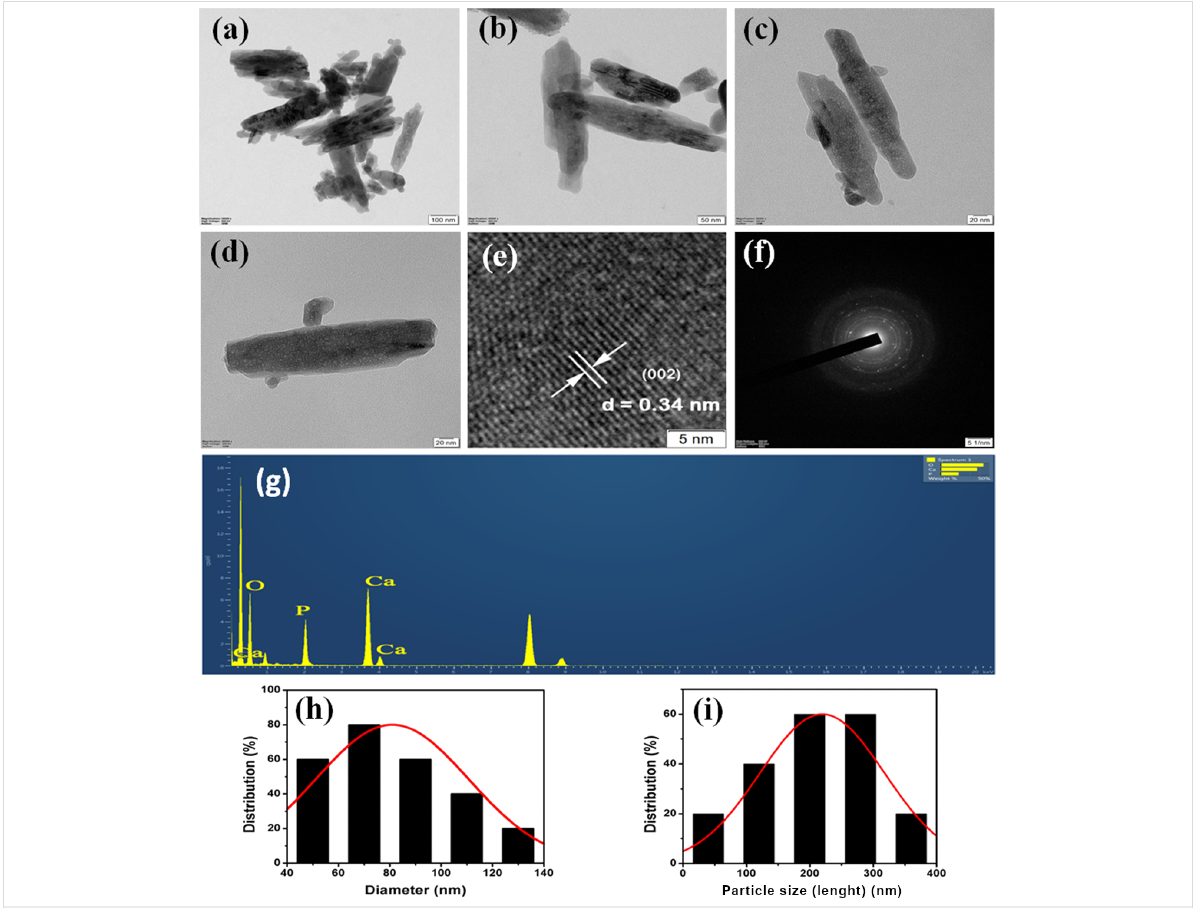
Figure 4: TEM images of hydroxyapatite (Hap) nanorods using cuttlefish bone powder as a precursor (CB-Hap NRs) at (a–d) different magnifications. (e) Calculation of d-spacing of CB-Hap NRs. (f) SAED pattern of CB-Hap NRs. (g) Elemental analysis of CB-Hap NRs and distribution of the (h) width and (i) length of CB-Hap